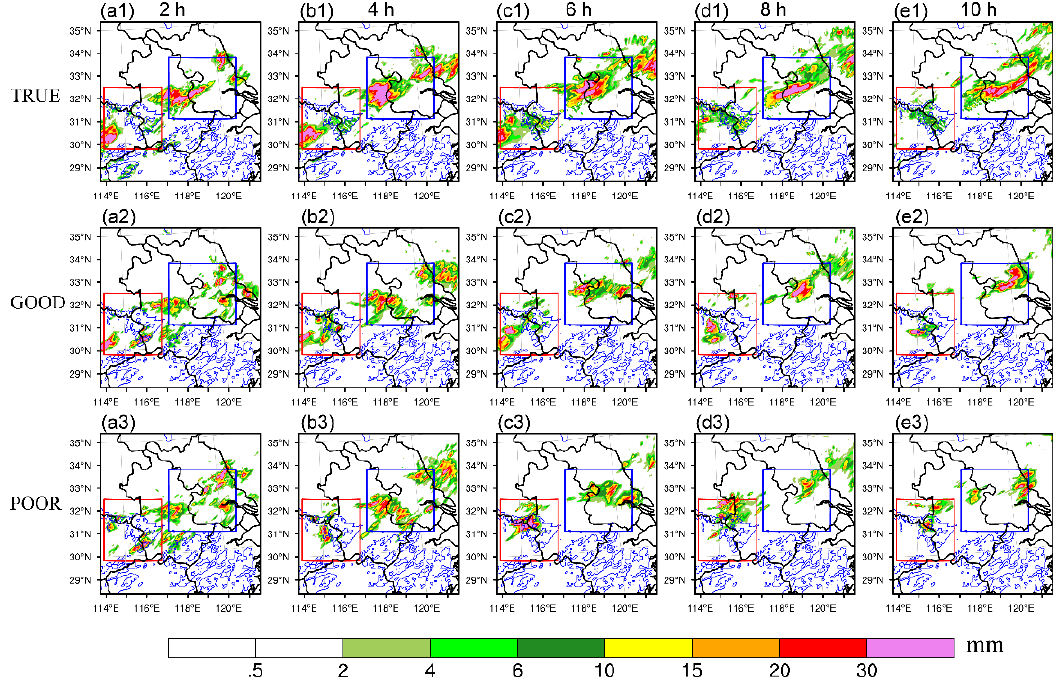
Figure 3. The 1 h accumulated precipitation for TRUE (top row), GOOD ( middle row ) and POOR ( bottom row ) at di ff erent valid times ( a1 – a3 ) 2 h, ( b1 – b3 ) 4 h, ( c1 – c3 ) 6 h, ( d1 – d3 ) 8 h, ( e1 – e3 ) 10 h. The blue contour indicates the terrain height (m, contoured every 600 m).